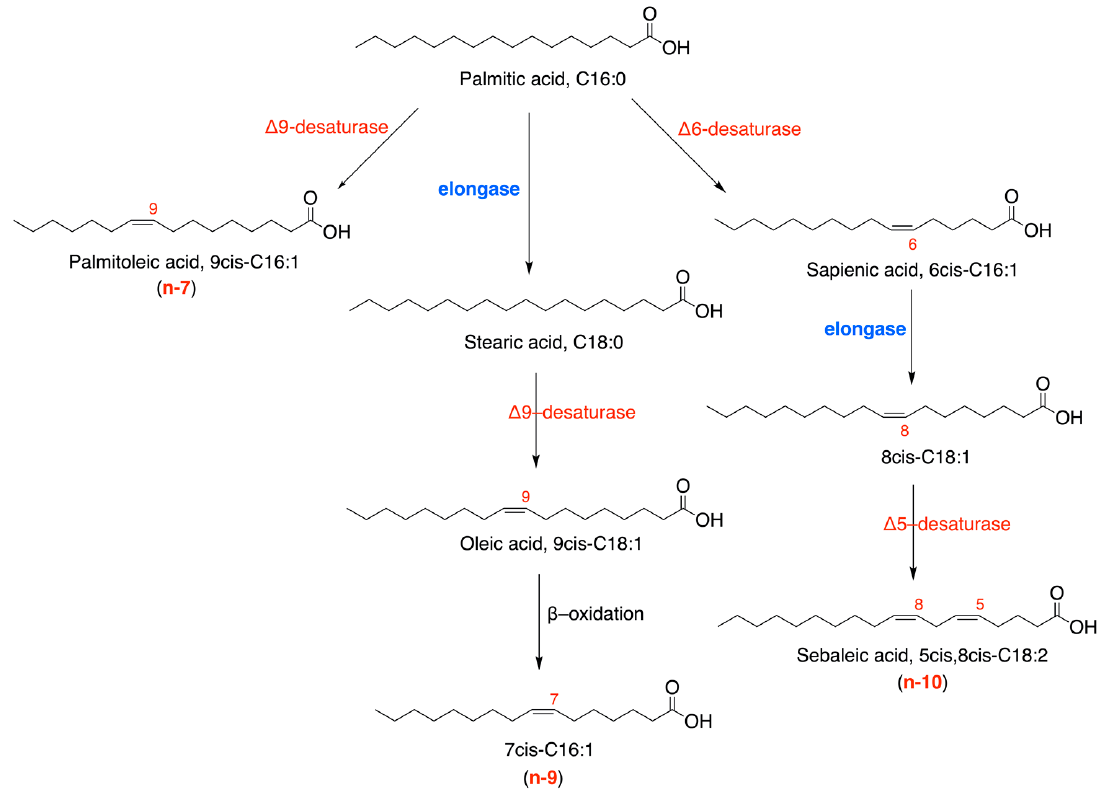
Figure 1. Main structures of the C16 monounsaturated fatty acids (MUFA) family and their biosynthetic pathways, starting from palmitic acid.